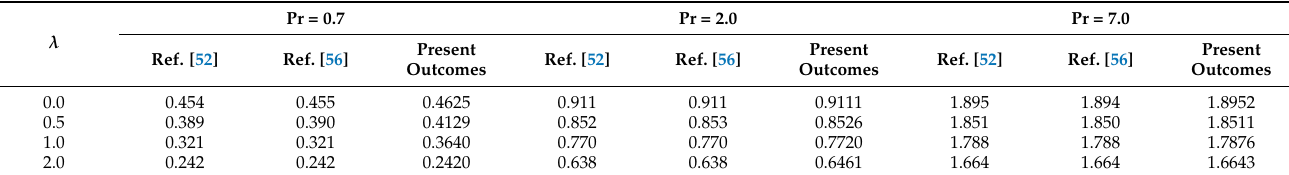
Table 3. Numerical findings of − θ (cid:48) ( 0 ) for diverse Pr inputs in case of β = 0, K 1 = 0, M = 0. Pr = 0.7 Pr = 2.0 λ